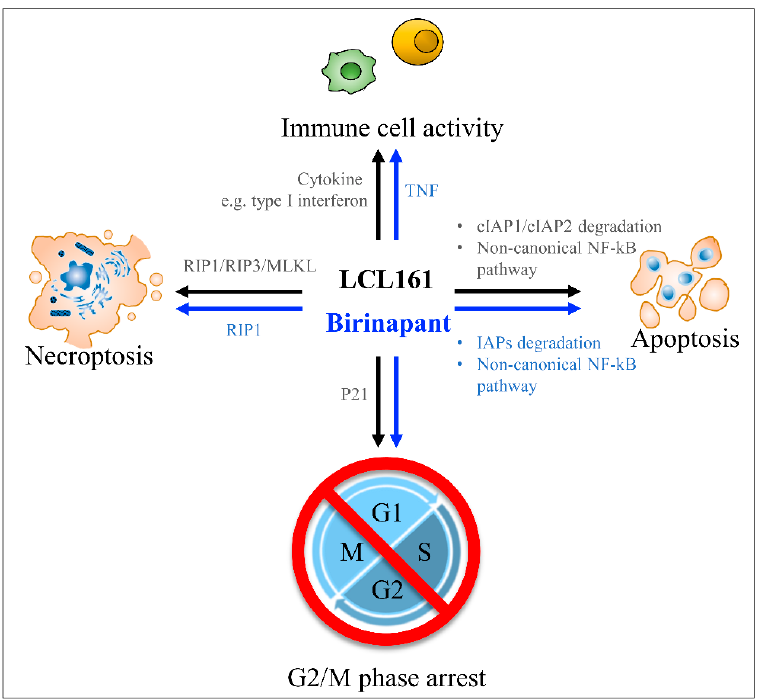
Figure 3. Anti ‐ cancer effects and the molecular mechanisms of action of LCL161 (black) and Figure 3. Anti-cancer effects and the molecular mechanisms of action of LCL161 (black) and birina- birinapant (blue) in cancer cells. pant (blue) in cancer